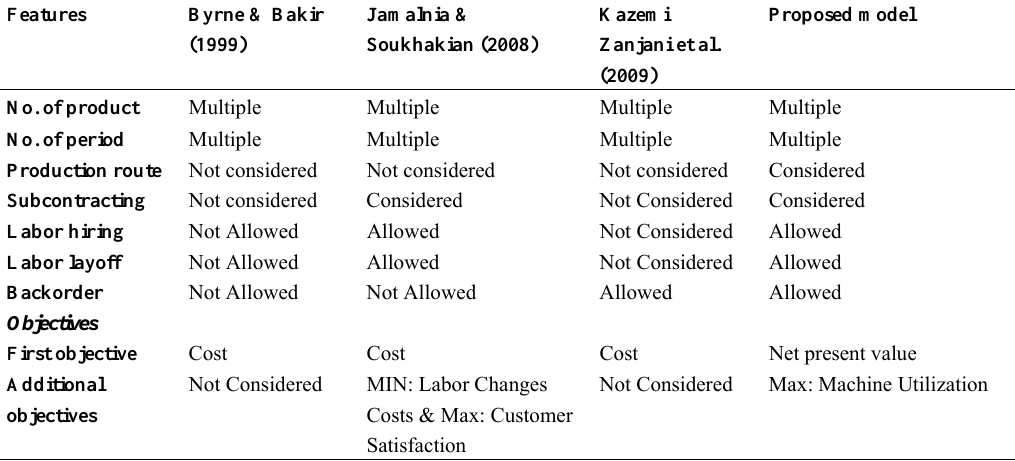
Table 9. Comparative analysis on features of different MPMP